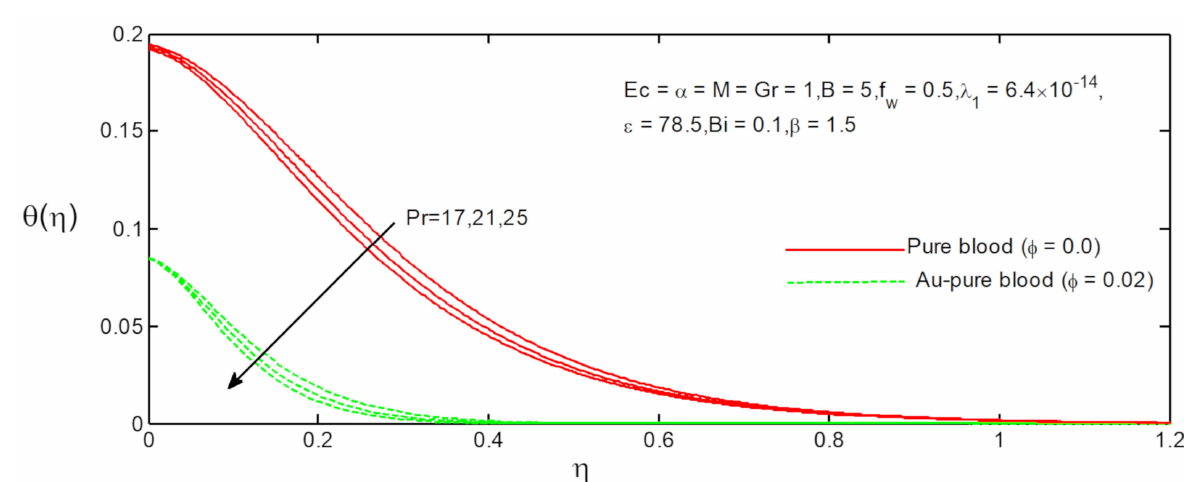
Figure 19. Influence of Pr on θ ( η )